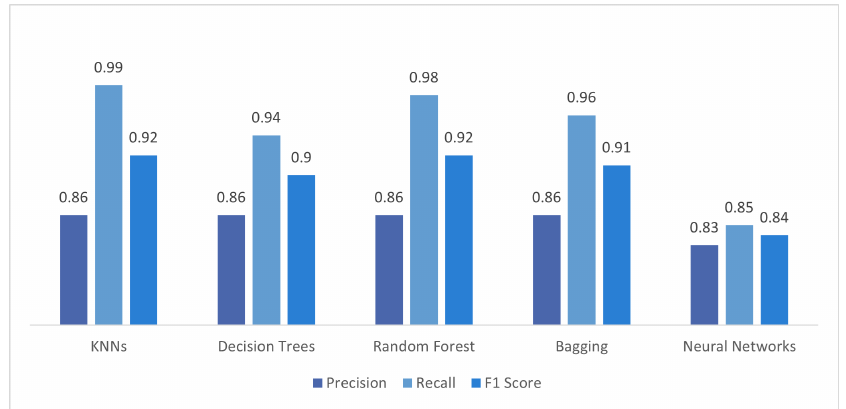
Figure 10. Comparison of ML metrics.